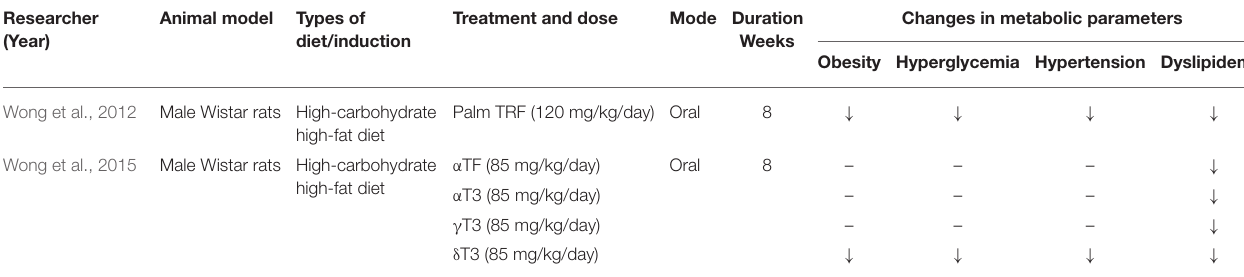
suppression of enzymatic activity and protein mass of